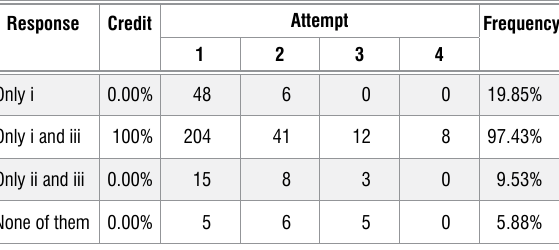
Analysis of student responses for Question 2 ( n =